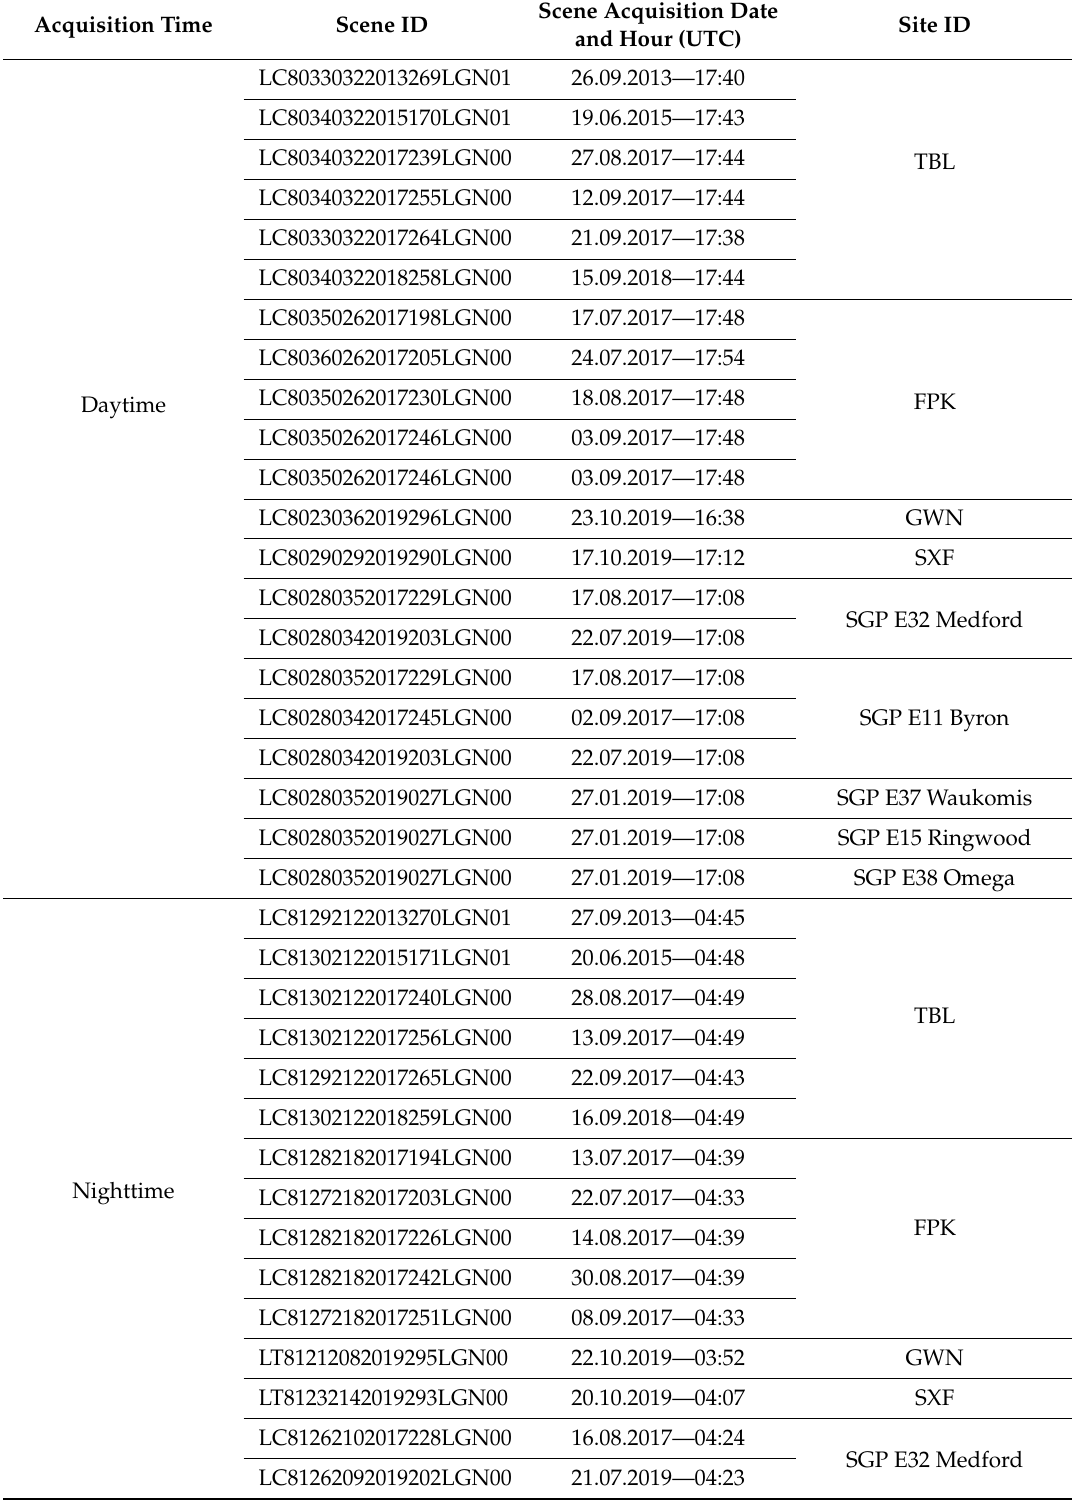
Table A1. The list of the daytime and nighttime Landsat 8 images with corresponding validation site